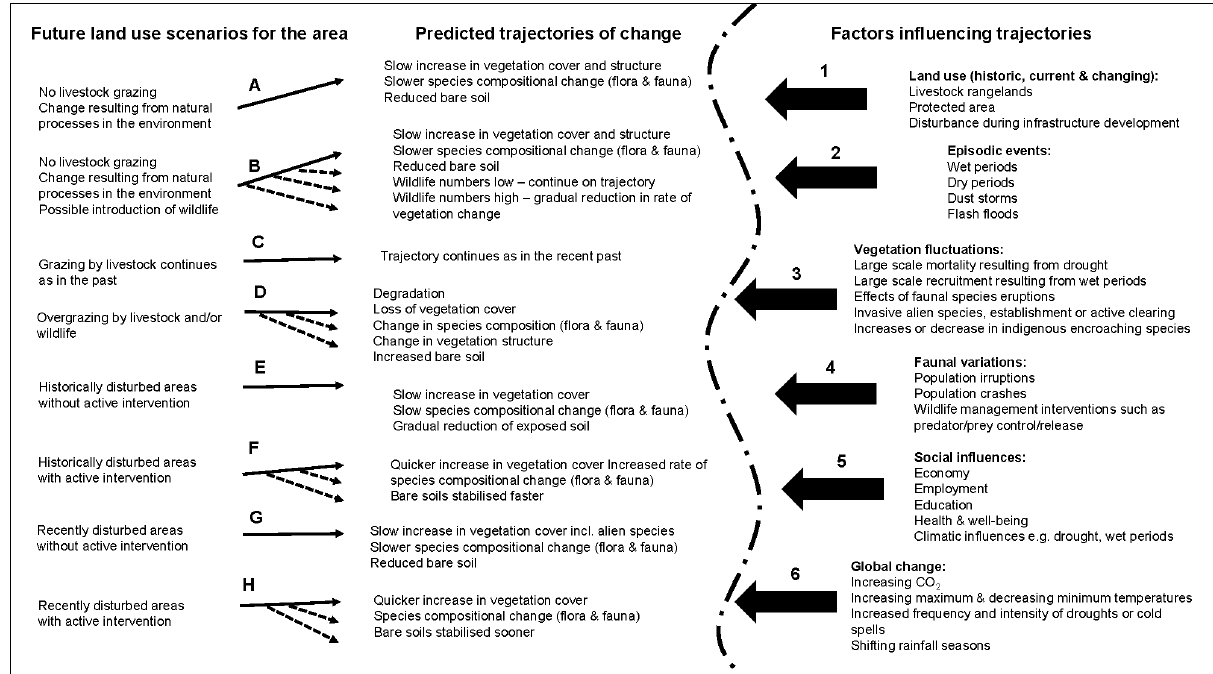
Figure 3: Conceptual model of future land-use scenarios, predicted trajectories of change and factors that could influence the predicted